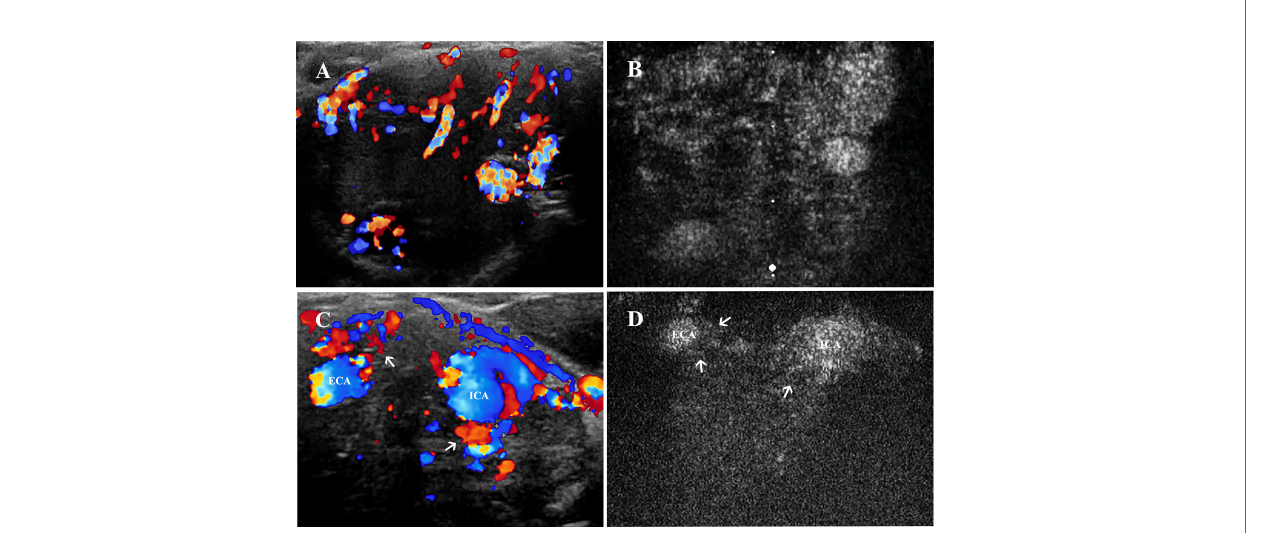
FIGURE 5 | Vascularity and feeding vessels of CBT lesions. (A) CDU showed a hypervascularity and hypoechoic mass located at carotid bifurcation, and (B) robust signal intensity could be seen 1 – 2 s after the enhancement of carotid arteries on CEUS. (C) Feeding vessels (thin arrows) of another CBT lesion could be observed deriving from both ECA and ICA on CDU and (D) on CEUS. CBT, carotid body tumor; CEUS, contrast-enhanced ultrasonography; CDU, color Doppler ultrasound; ICA, internal carotid artery; ECA, external carotid